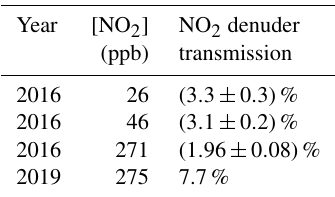
Table 1. Effect of inserting a single channel-activated carbon de- nuder in between an NO 2 source and the TD-CRDS. Errors were measured for the 2016 measurements and are reported as the stan- dard deviation.